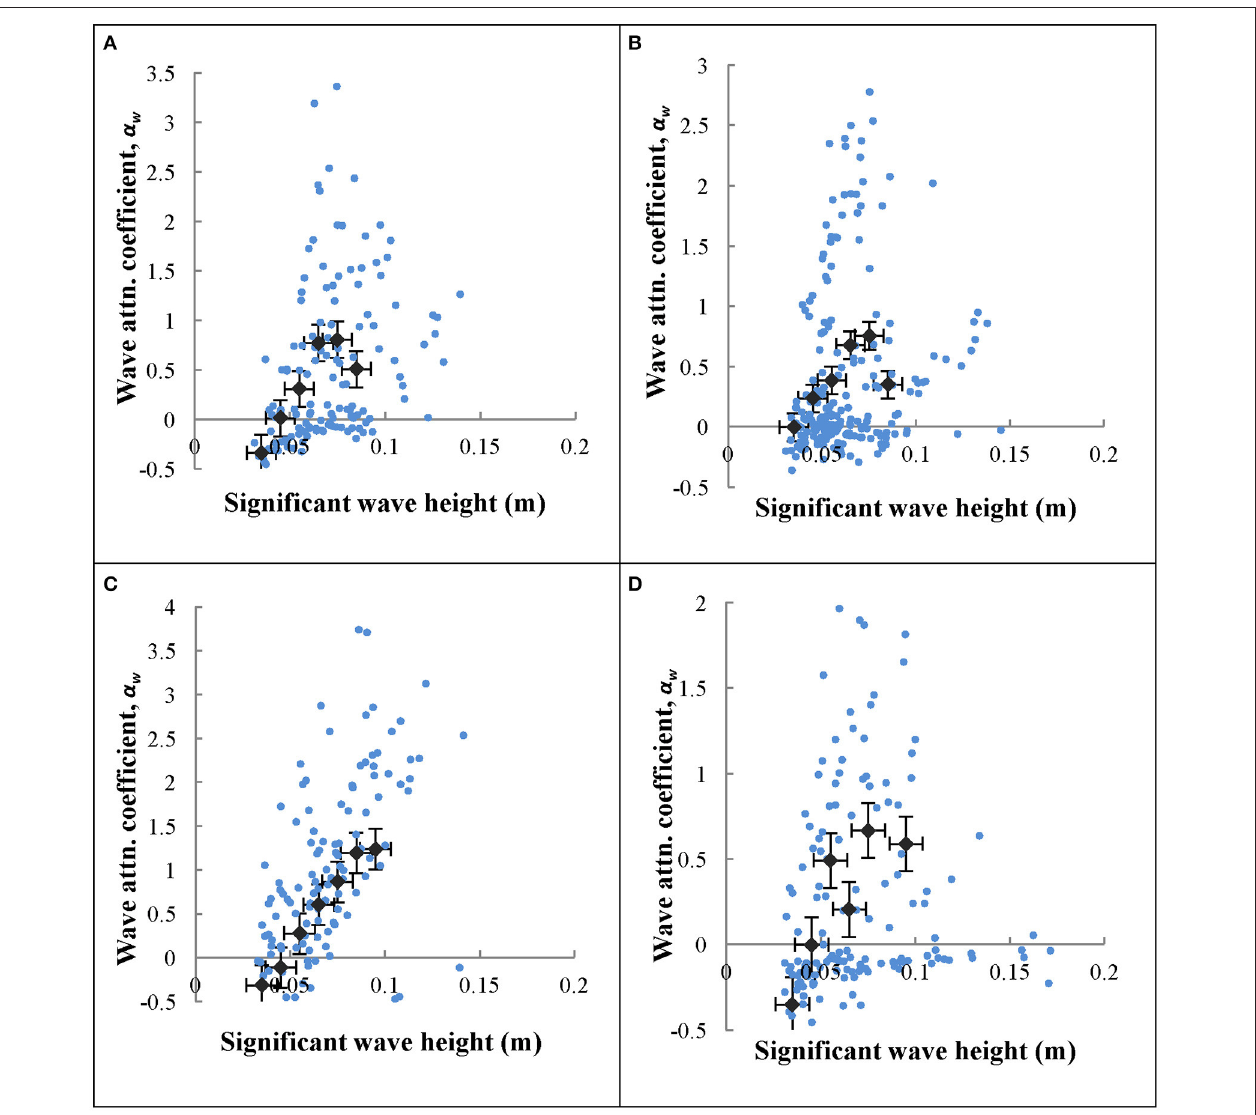
FIGURE 6 | Significant wave height (H s ) vs. wave attenuation coefficient ( α w ) for north winds across (A) April 2012, (B) July 2012, (C) October 2012, (D) January 2013. Wave height data were averaged in 0.01m bins and plotted along with the raw data as gray diamonds. Bins that had fewer than 10 data points were excluded. Error bars indicate standard